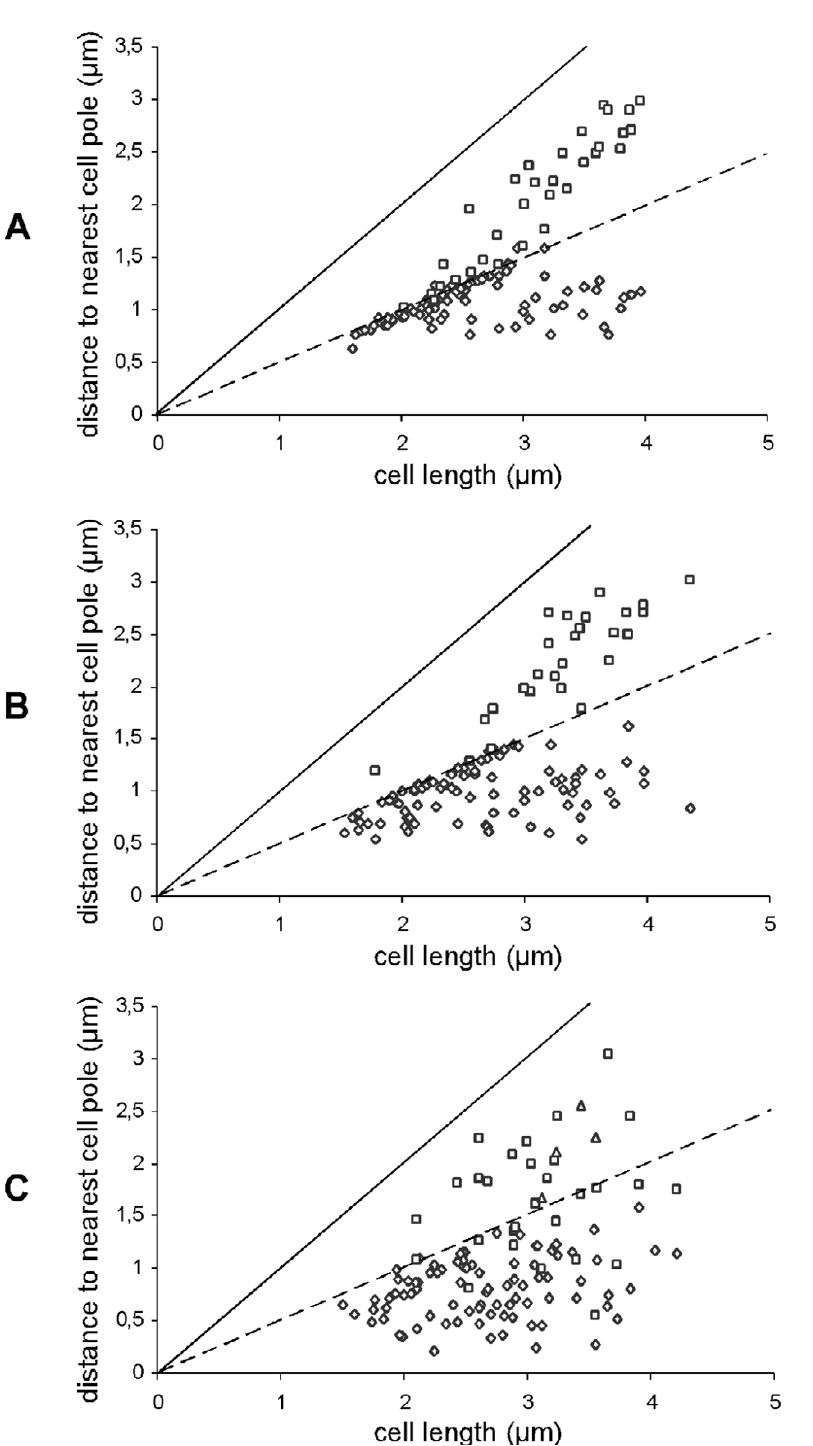
Figure 3 Graphical representation of the position of the replication machinery within wild type or actin-depleted cells. The distance of DnaX-CFP foci to the nearest cell pole was measured and plotted relative to cell size. A) wild type cells, B) cells 2–3 doubling times after depletion of Mbl, C) cells 2–3 doubling times after depletion of MreB. (cid:154) single focus of focus closest to a pole, (cid:1) second focus, ∆ third